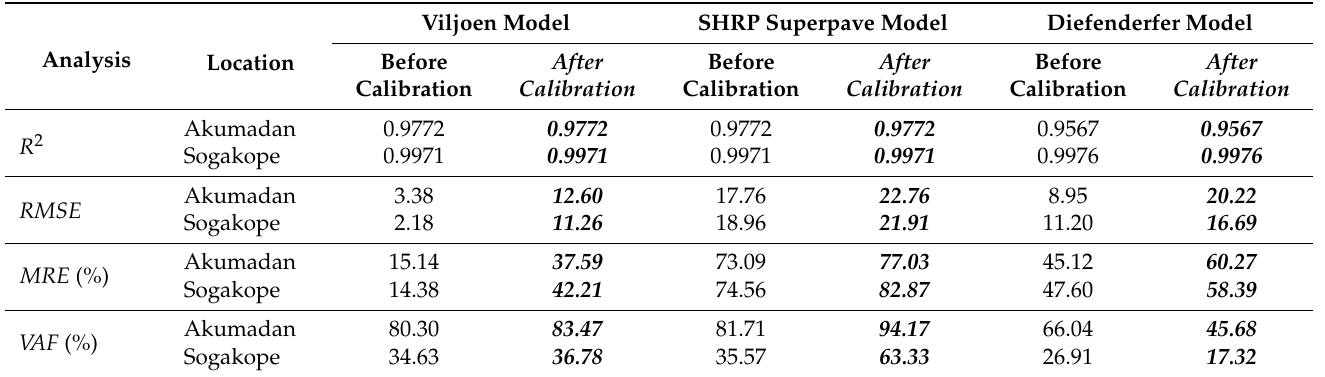
Table 3. Results of statistical analysis of predicted temperature values at other